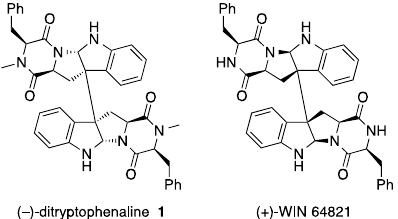
Figure 2. Chemical structures of dimeric diketopiperazine alkaloids, (–)-ditryptophenaline 1 [7] and (+)-WIN 64821 [8].